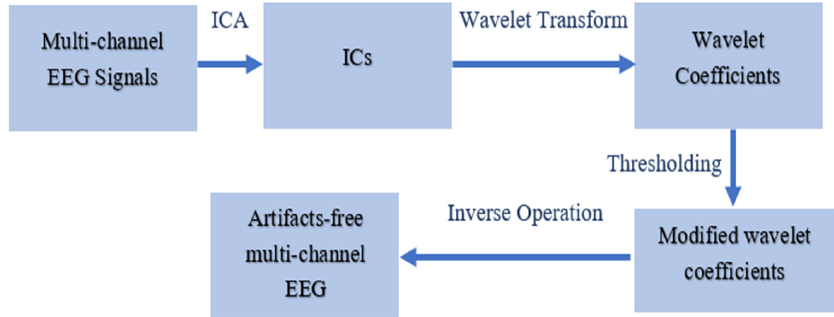
Figure 5. Basic flow chart of wavelet-ICA based EEG denoising. Figure 6. ICA-wavelet-based EEG denoising.